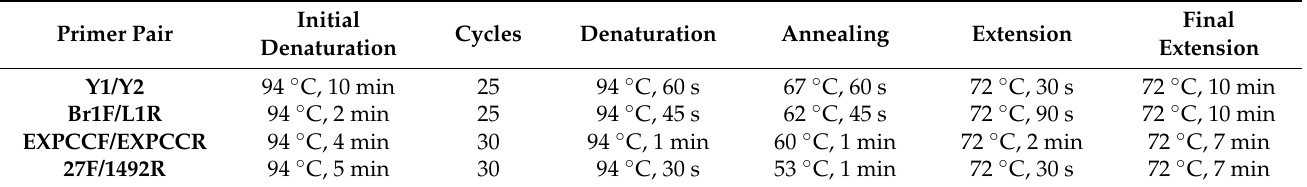
Table 1. PCR conditions for specific detection of Pectobacterium spp., P. brasiliense , P. carotovorum and amplification of 16S